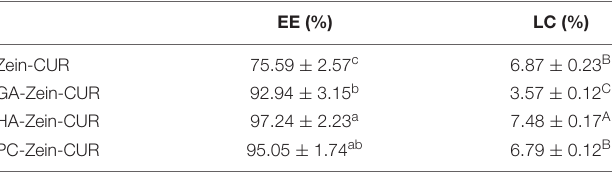
TABLE 1 | Encapsulation efficiency (EE) and loading capacity (LC) of CUR-loaded composite